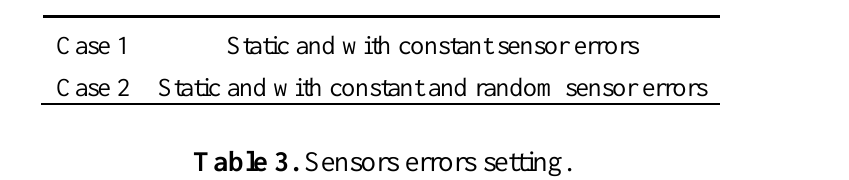
Table 2. Alignment under the two conditions.